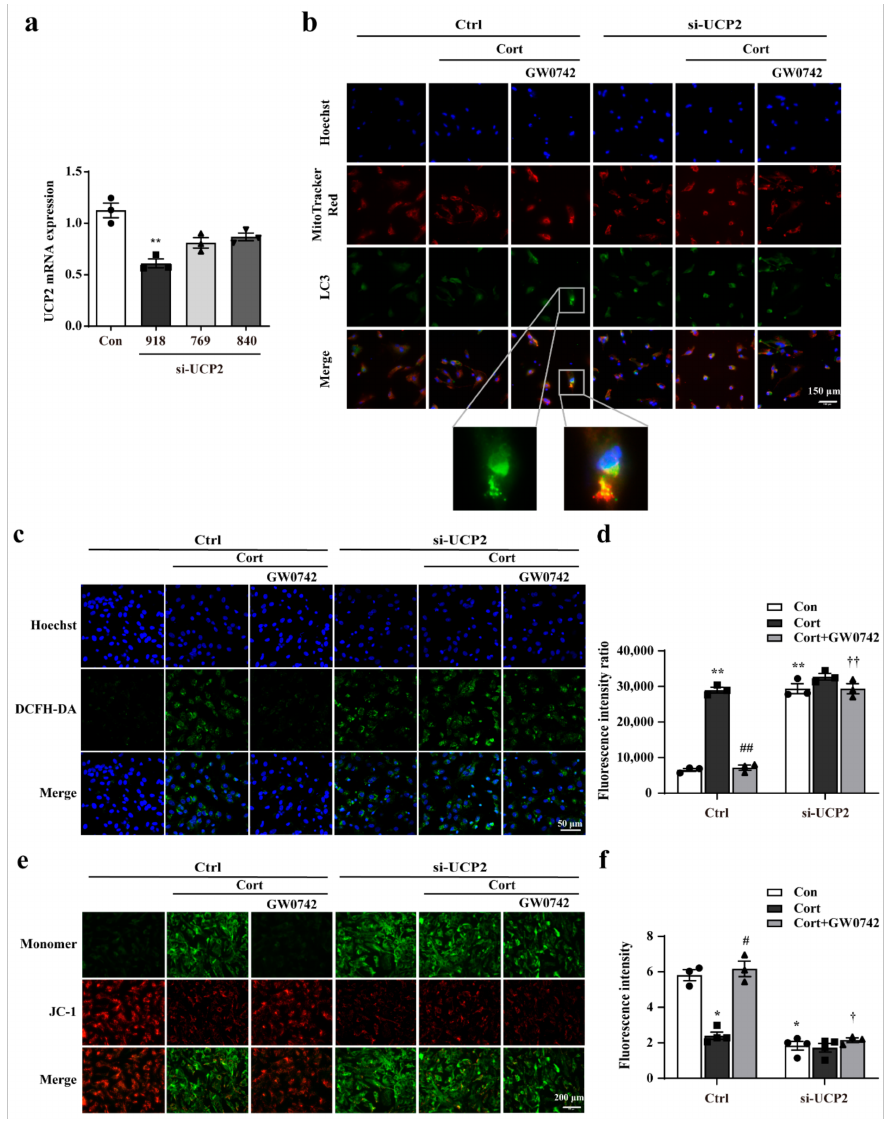
Figure 5. GW0742 ameliorates mitochondrial damage via UCP2-mediated mitophagy in